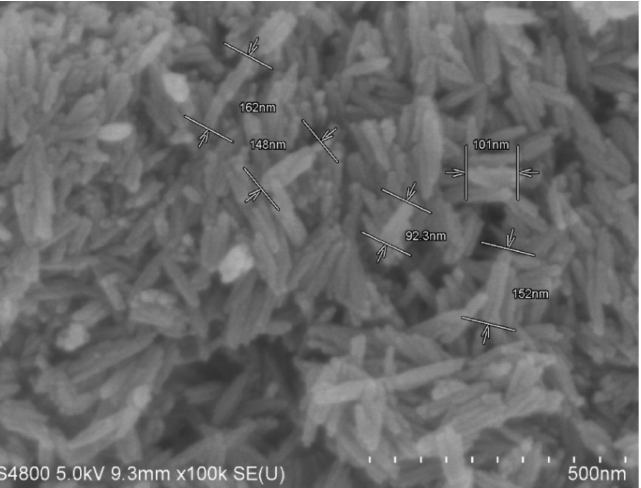
Figure 1. SEM image of Nano-Fe 2 O 3 . In contrast, the Nano-Fe 2 O 3 is intercepted with a certain thickness of the model to eliminate the error of uneven charge distribution caused by the thinness of the Nano-Fe 2 O 3 . The detailed molecular composition is shown in Figure 2.